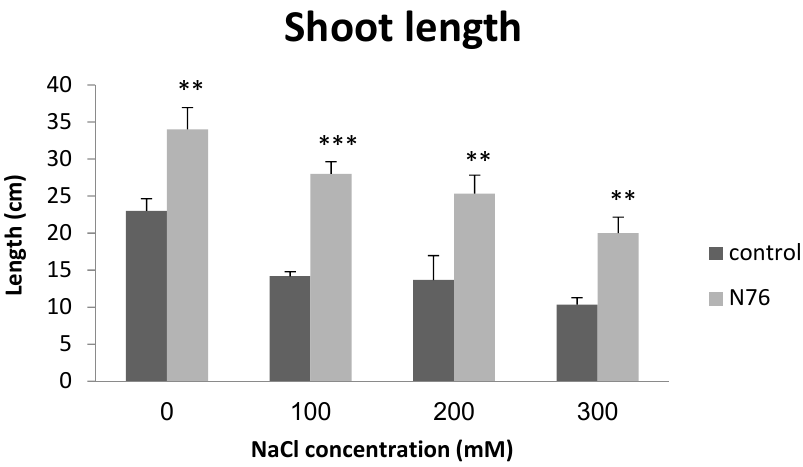
Figure 5. Effect of P. azotoformans on the shoot length of wheat seedlings under different NaCl concentrations. **: significant difference ( p < 0.005); ***: significant difference ( p < 0.001).